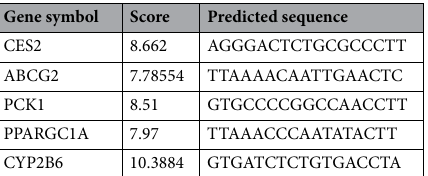
Table 4. Predicted sequences that PXR bind on the gene promoters listed below with the highest scores.